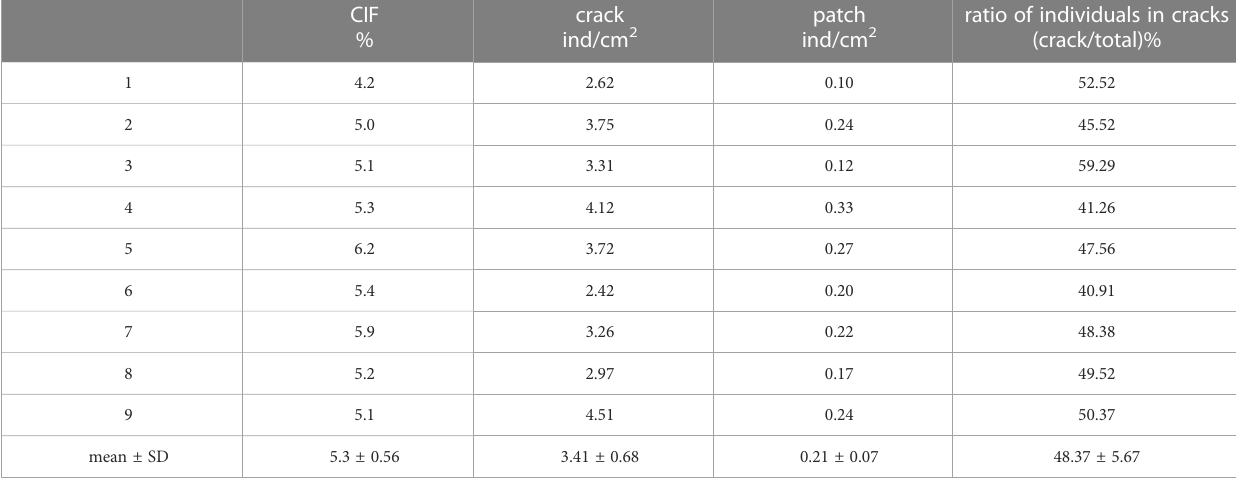
TABLE 3 Variations in seedling densities between mud cracks and patches in the nine experimental containers.